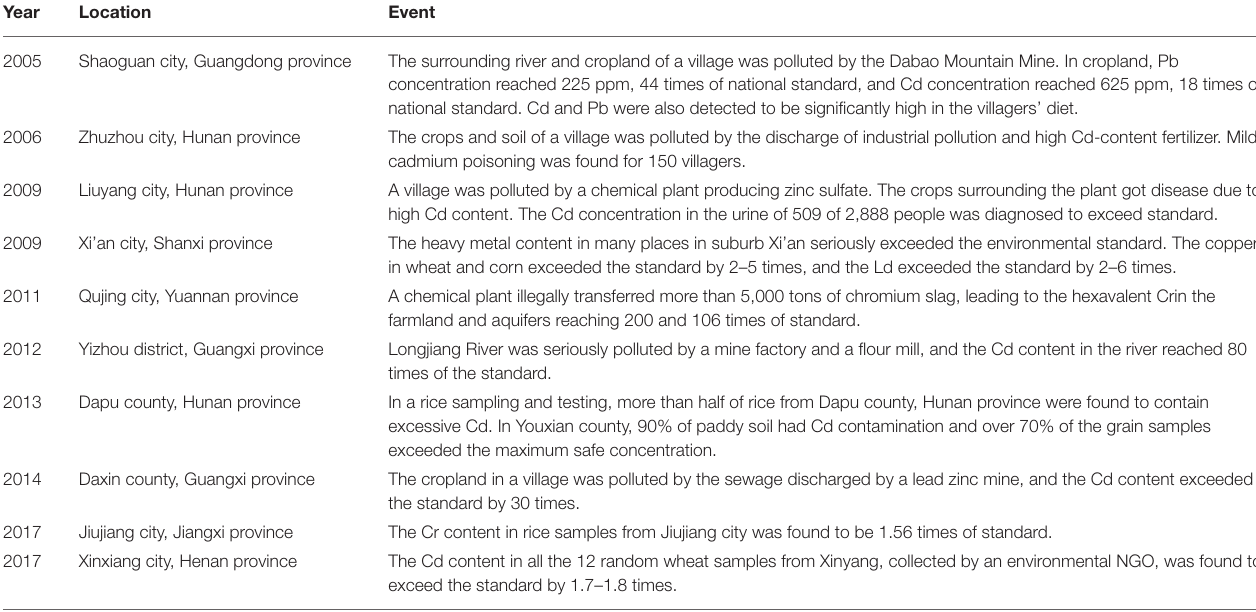
TABLE 3 | Ten typical heavy metal contamination events in the past two decades.